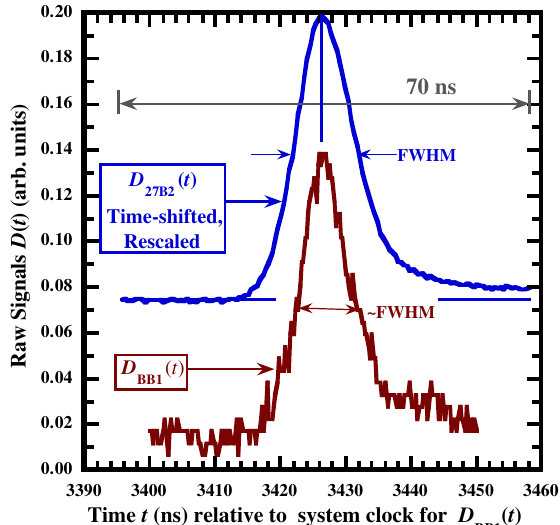
FIG. 4. Overlay comparison of noise in raw data between two nTOF channels, BB1 and 27B2. (Data from channel 27B2 have been shifted earlier by 118 ns and rescaled in this comparison).